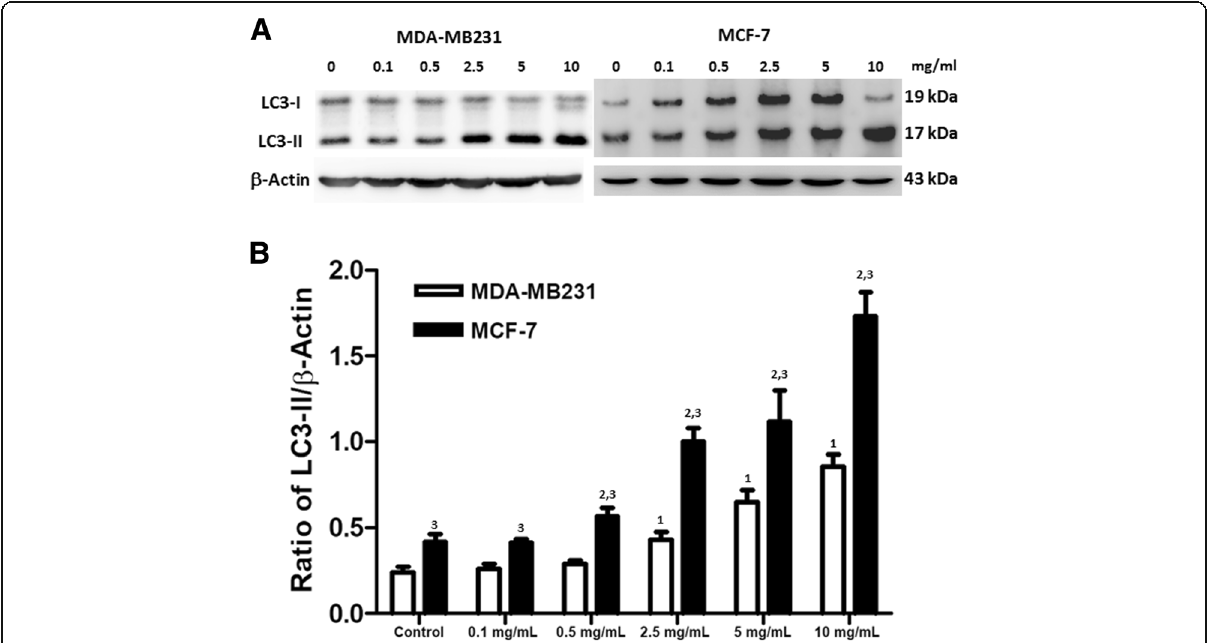
Fig. 4 Expression of autophagy-related proteins. MDA-MB231 and MCF-7 cells were treated with different concentrations of T33 for 48 h and a expressions of LC3-I and LC3-II proteins in MDA-MB231 and MCF-7 cells were detected with immunoblotting. Ratios of LC3-II/ β -Actin in b MDA- MB231 and MCF-7 cells are shown. Similar results were observed in triplicate experiments. The superscripts 1, 2, and 3 refer to significant differences ( P < 0.05) from the MDA-MB231 control, MCF-7 control and MDA-MB231,